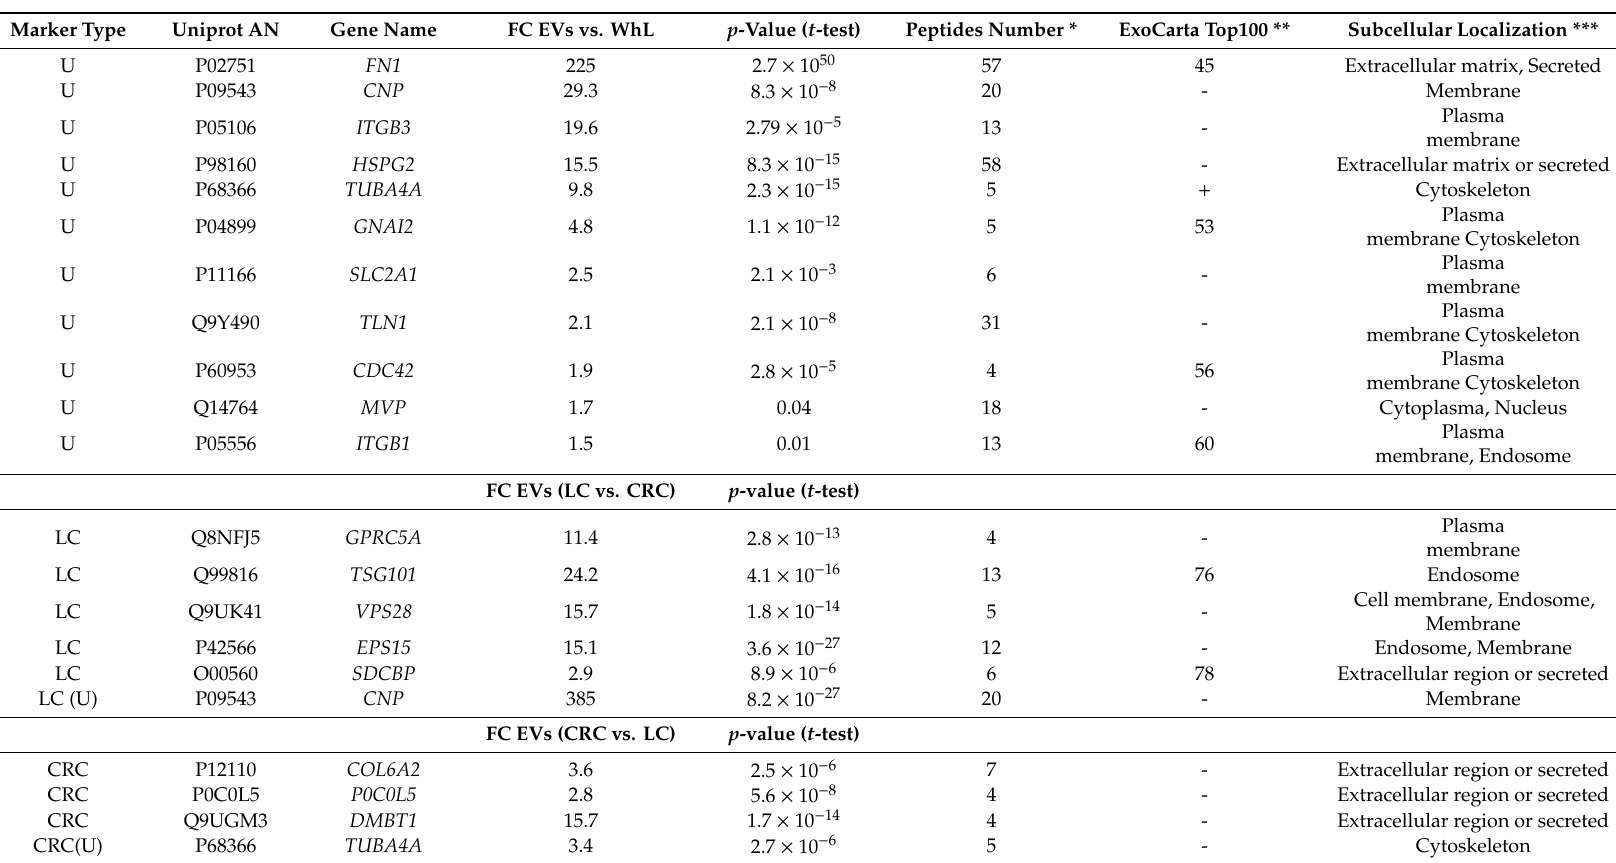
Table 2. Label-free results (fold change, p -value); annotations in terms of subcellular localization (Uniprot database) and frequency of detection based on the “ExoCarta Top100 list” (http: // exocarta.org /